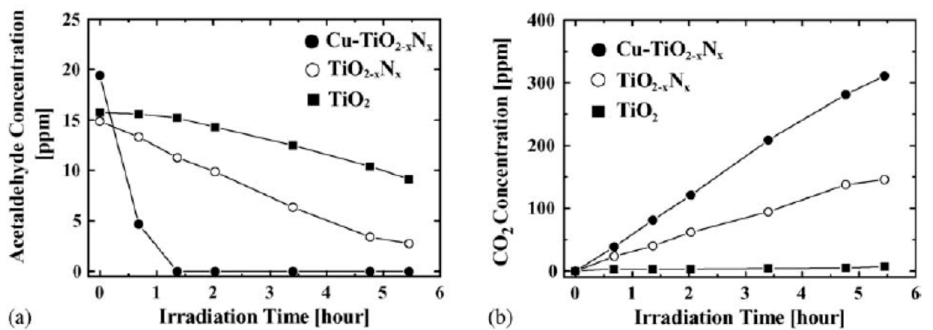
Figure 18. Concentrations of acetaldehyde ( a ) and CO 2 ( b ), as a function of visible light irradiation time on bare TiO 2 , TiO 2-x N x and Cu-loaded TiO 2-x N x . Reprinted from [73], Copyright 2020, with permission from Elsevier.